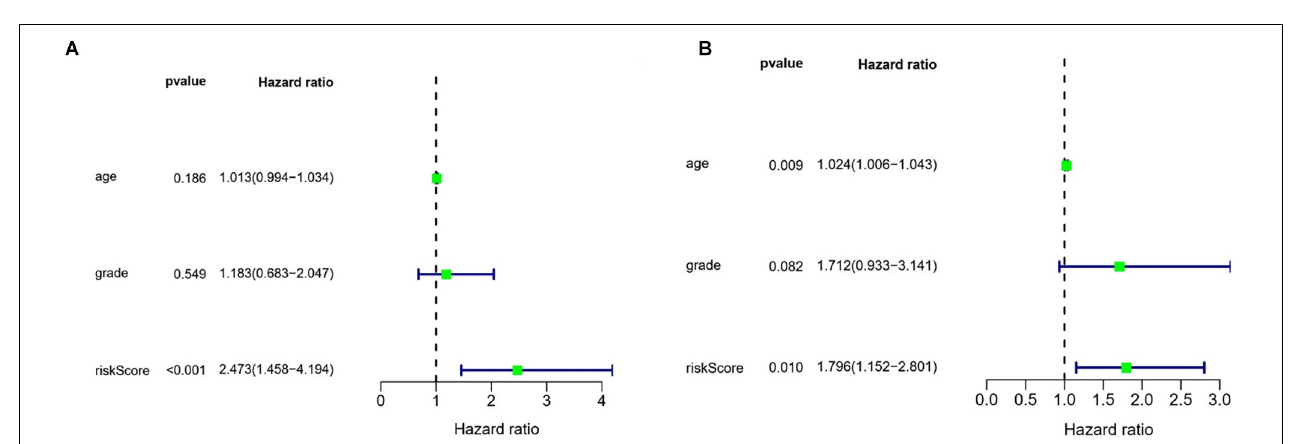
FIGURE 8 | Nomogram for predicting 1-year, 3-year, and 5-year OS of OSC patients in TCGA database.